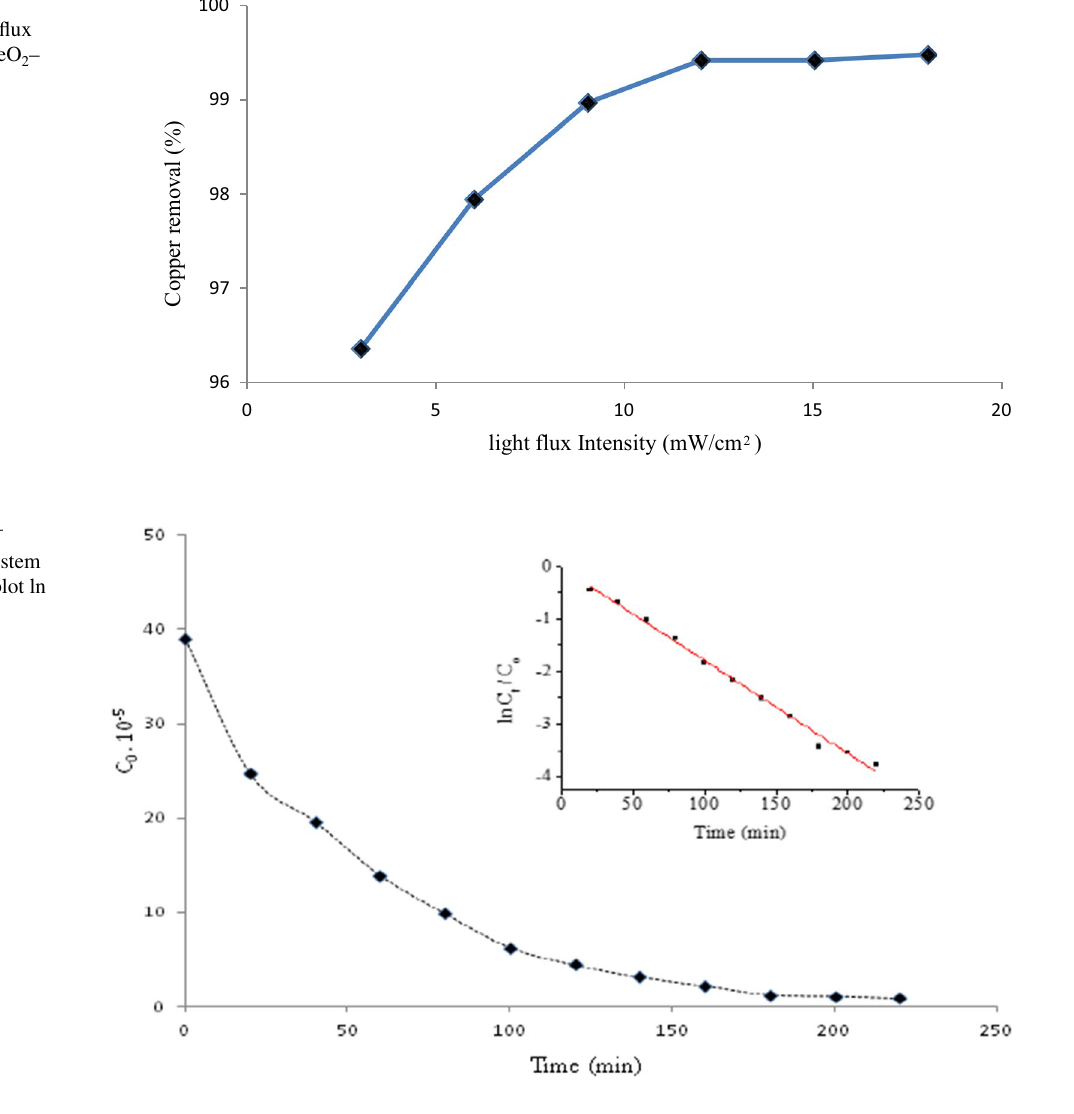
Fig. 7 Percentage of Cu 2+ reduction versus the light flux on the hetero-system CuFeO 2 – ZnO